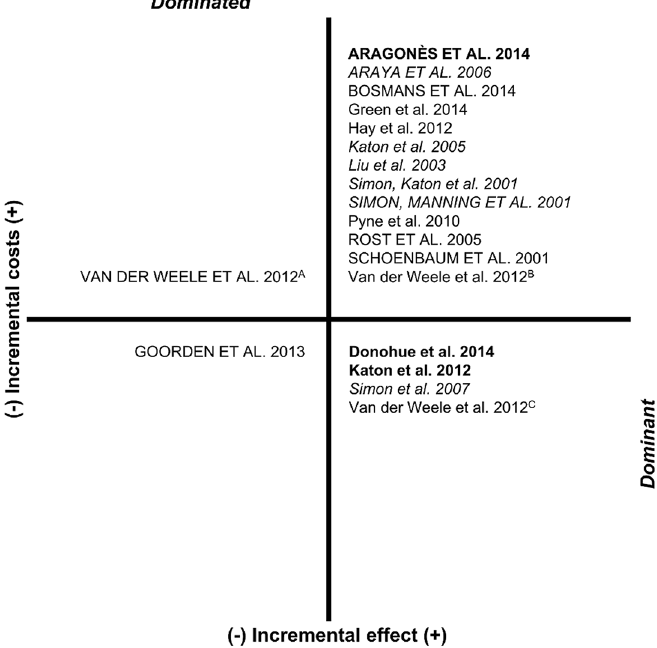
Fig 2. Cost effectiveness plane for studies with costs per DFD/QALY. In capitals: studies with a societal perspective, in italics: studies with costs per DFD, in bold: studies with costs per DFD and QALY, A Patients aged 75 – 80, effectiveness measurement instrument EQ-5D; B Patients aged 75 – 80, effectiveness measurement instrument SF-12, C Patients aged (cid:1) 80.